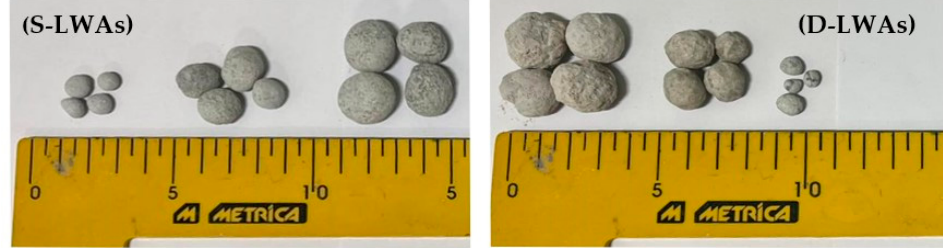
Table 3. Mix design used for the double-step cold-bonding granulation.